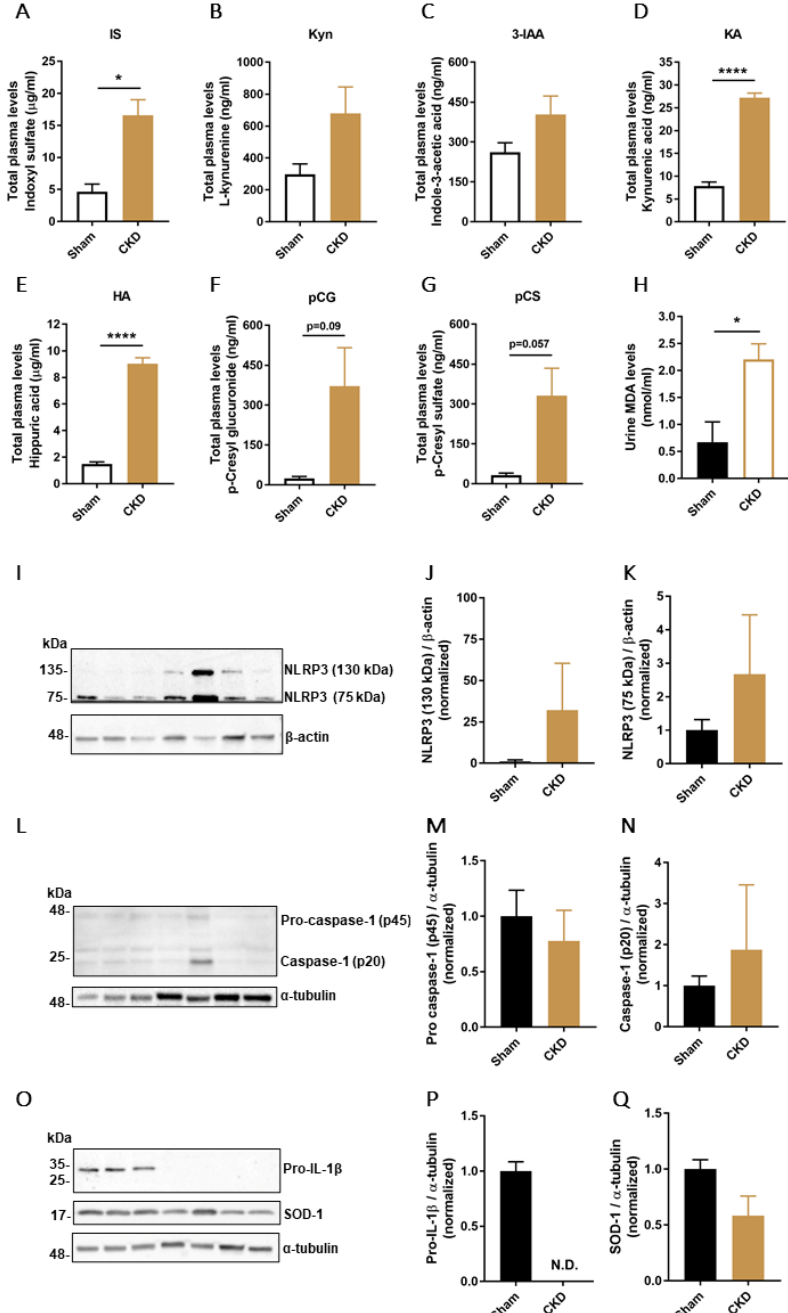
Figure 7. PBUTs plasma levels, oxidative damage and NLRP3 inflammasome components protein expression in CKD model. Quantification of total plasma levels ( μ g/mL or ng/mL) of ( A ) indoxyl sulfate (IS), ( B ) L-kynurenine (Kyn), ( C ) Indole-3-acetic acid (3-IAA), ( D ) kynurenic acid (KA), ( E ) hippuric acid (HA), ( F ) p-cresyl glucuronide (pCG) and G ) p-cresyl sulfate (pCS) in Sham and CKD rats. ( H ) Urine MDA levels (nmol/mL) in Sham and CKD animals. ( I – K ) Representative Western blot and quantification of relative expression of NLRP3 in Sham and CKD rats; normalized to β -actin. ( L – N ) Representative Western blot and quantification of relative expression of pro-caspase-1 (p45) and caspase-1 (p20) in Sham and CKD rats; normalized to α -tubulin. ( O ) Representative Western blot of pro-IL-1 β and SOD-1 in Sham and CKD rats. Quantification of relative expression of ( P ) pro-IL-1 β and ( Q ) SOD-1; normalized to α -tubulin. Data are derived from n = 3 Sham and n = 4 CKD animals and presented as mean ± SEM. * p < 0.05, **** p < 0.0001 (Unpaired t